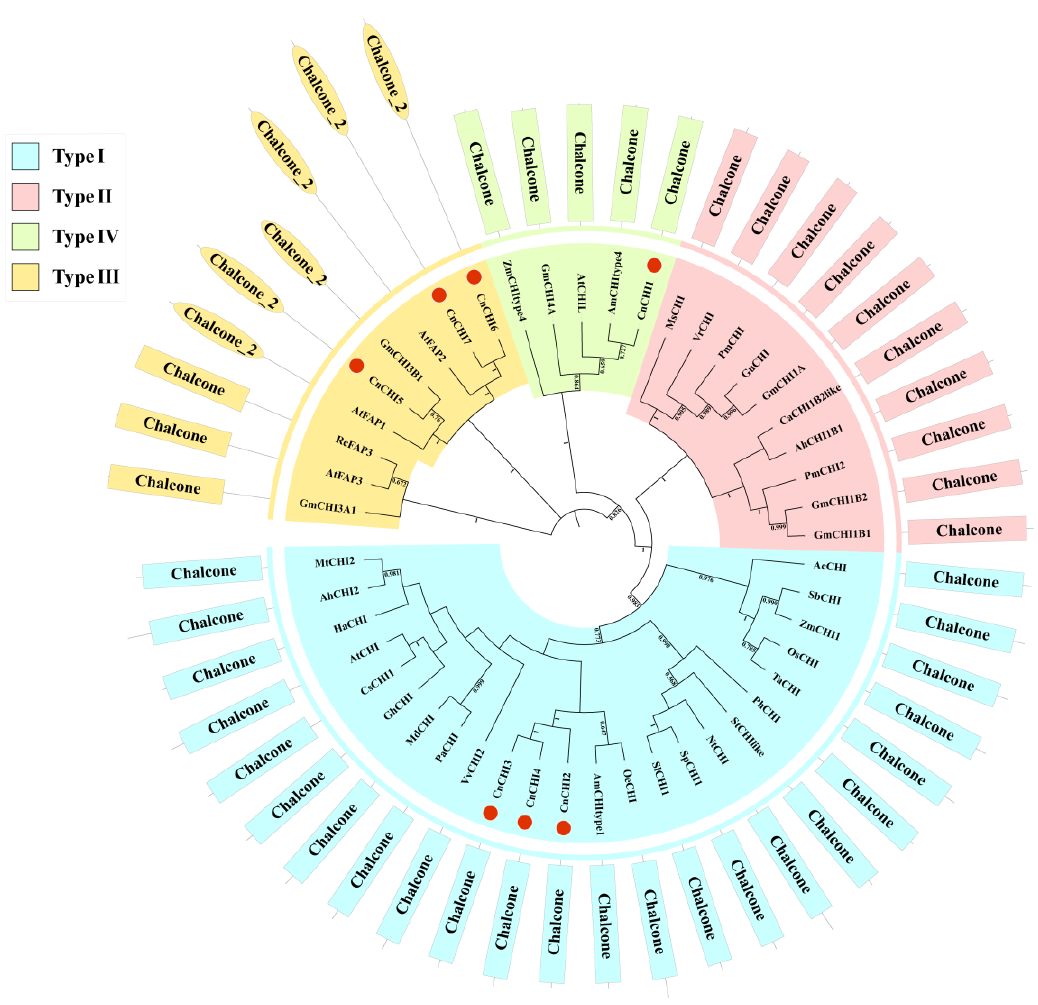
Figure 2. Phylogenetic analyses of the deduced protein sequences of CHIs. The different colors represent different subgroups. Information pertaining to the CHI protein domains was obtained from Pfam and provided in the outer circle of the phylogenetic tree. The GenBank accession numbers are as follows: AtCHI NP_191072.1, NtCHI NP_001312216.1, AtCHIL AAL36093.1, GmCHI1A